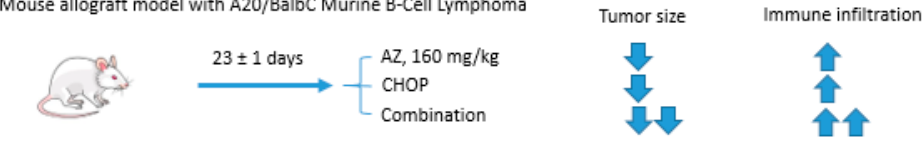
Figure 8. Graphical outline of the study on AZ+CHOP combination reported by Mehes et al.